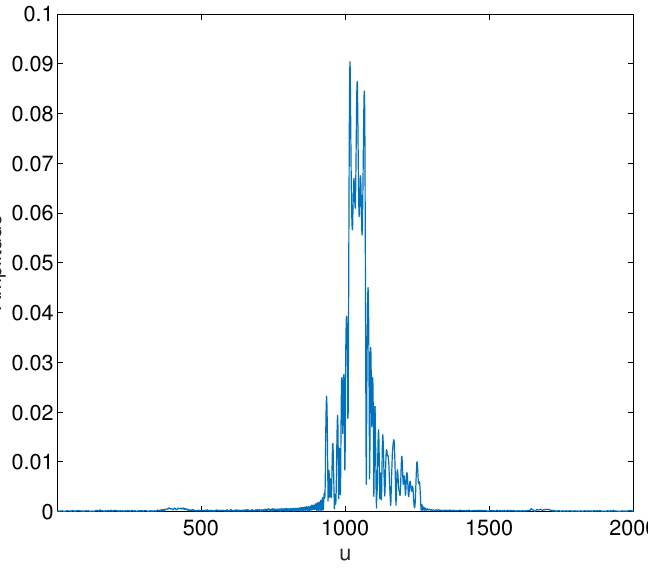
Figure 7. Linear canonical transform of the signal after multipath interference